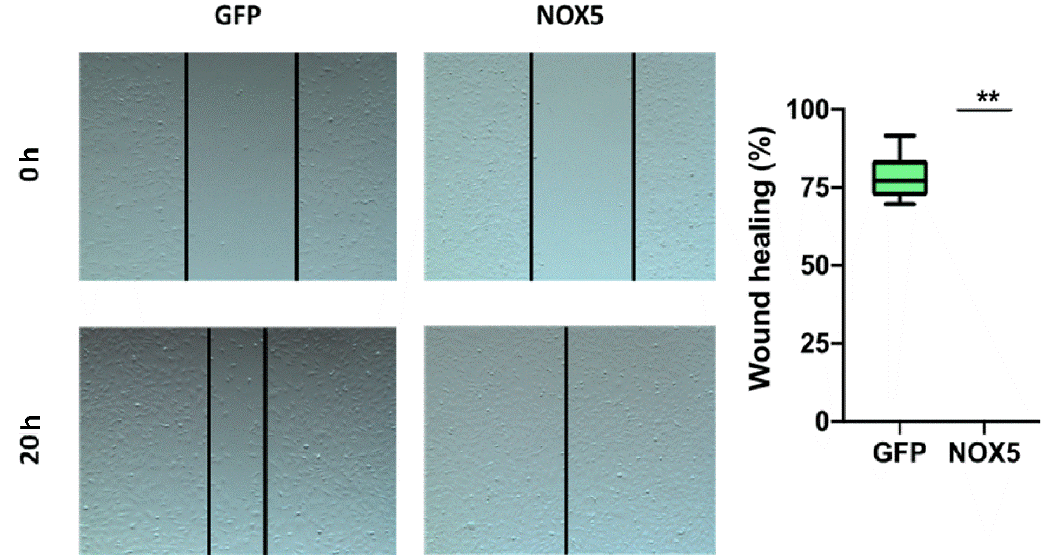
Figure 11. NOX5- β overexpression promotes cell migration in hCMEC/D3 cells. Left panel: representative images of wound-healing assay. Pictures were taken 0 and 20 h after the scratch. Right panel: wound-healing assay quantification. GFP: GFP-infected hCMEC/D3 cells; NOX5: NOX5- β -infected hCMEC/D3 cells. ( n = 6) ** p < 0.01 vs. GFP-infected cells. Data presented as mean ± SEM.